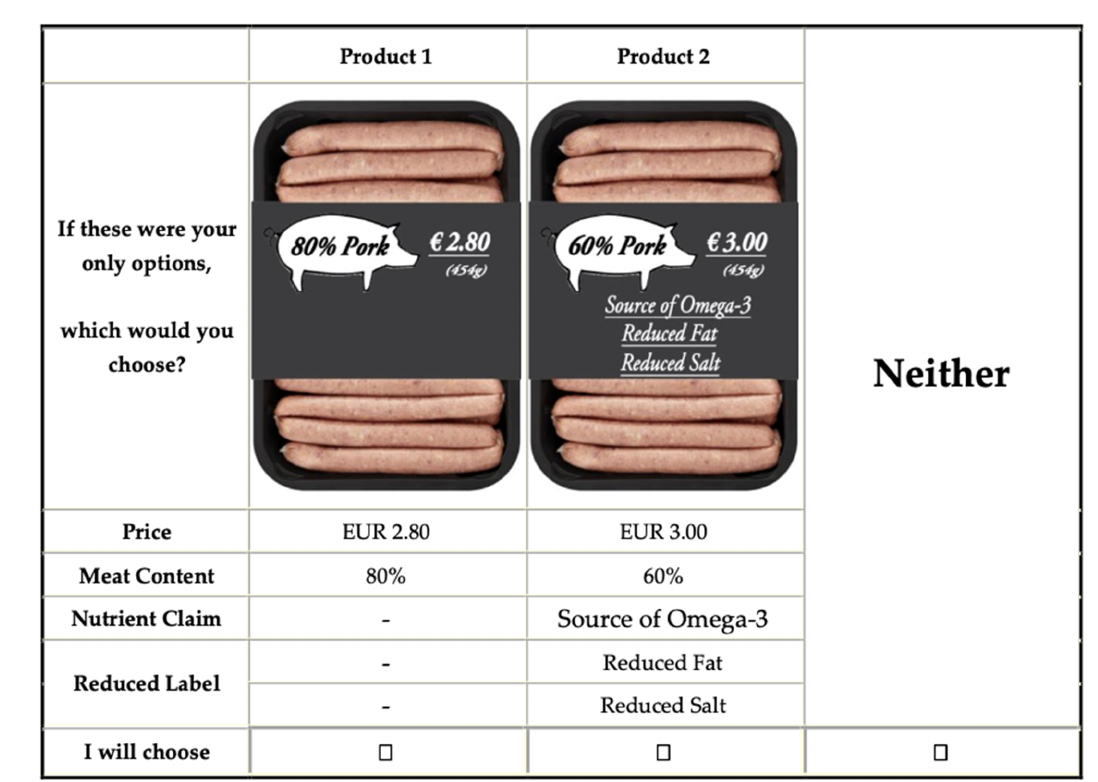
Figure A1. Choice set 1 in the questionnaire